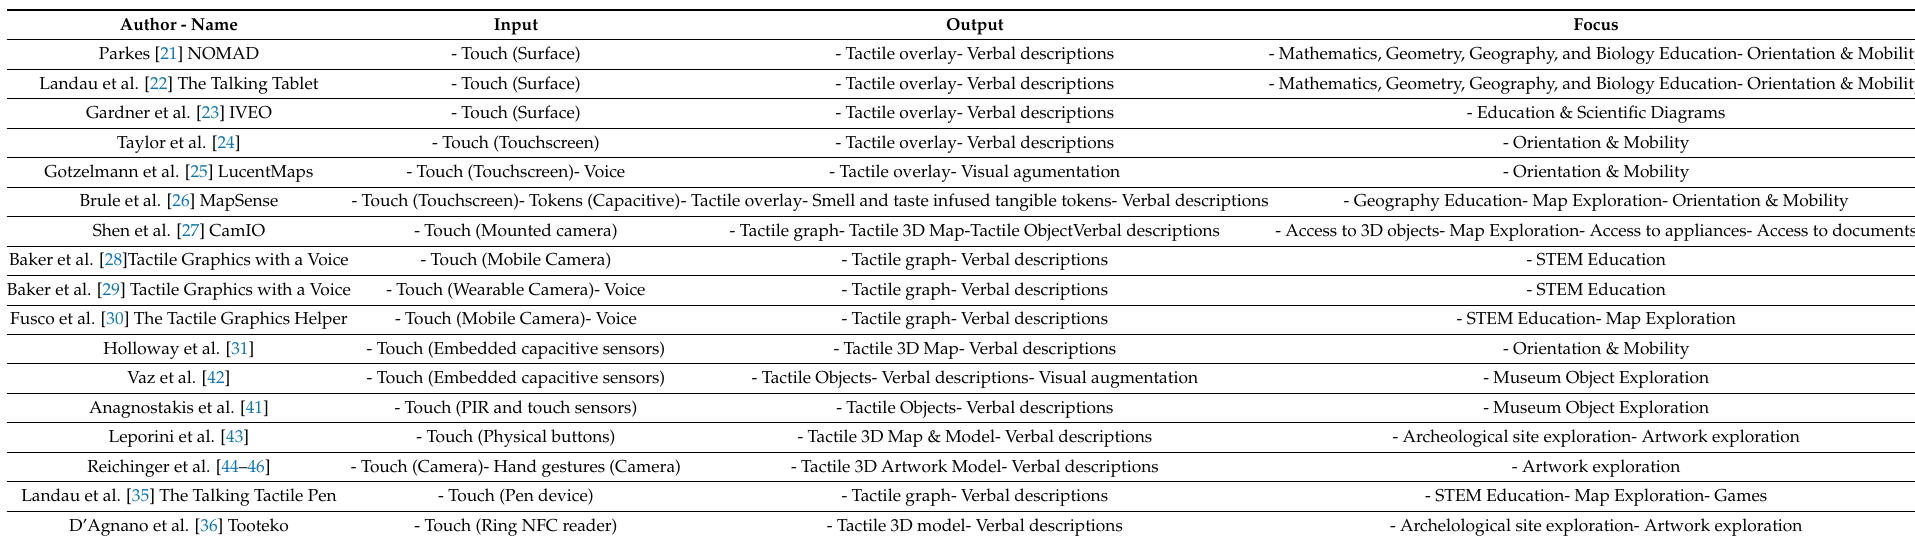
Table A1. Interactive tactile graphics and multimodal guide